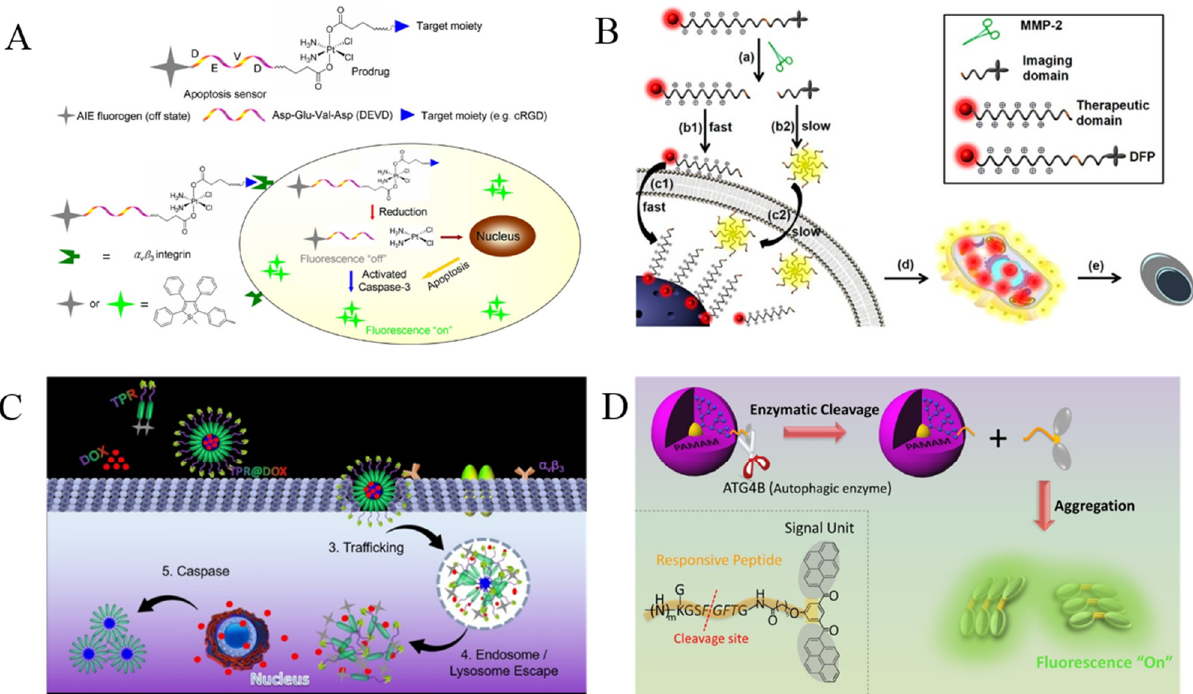
Figure 4. ( A ) Schematic illustration of the targeted theranostic platinum (IV) prodrug with a built- in aggregation-induced emission (AIE) light-up apoptosis sensor for noninvasive, in situ early evaluation of its therapeutic responses. Reprinted with permission from ref. [50]. Copyright 2014, American Chemical Society. ( B ) Schematic illustration showing the probe DFP for rapid drug delivery and drug release tracking in MMP-2 over-expression living cells. Reprinted with permission from ref. [51]. Copyright 2016, American Chemical Society. ( C ) Schematic illustration of TPR@DOX for tumor treatment and apoptosis monitoring. Reprinted with permission from Reference [52]. Copy- right 2021, American Chemical Society. ( D ) Caspase-3/7-sensing mechanism of CP1. Reprinted with permission from ref. [53]. Copyright 2017, American Chemical Society.